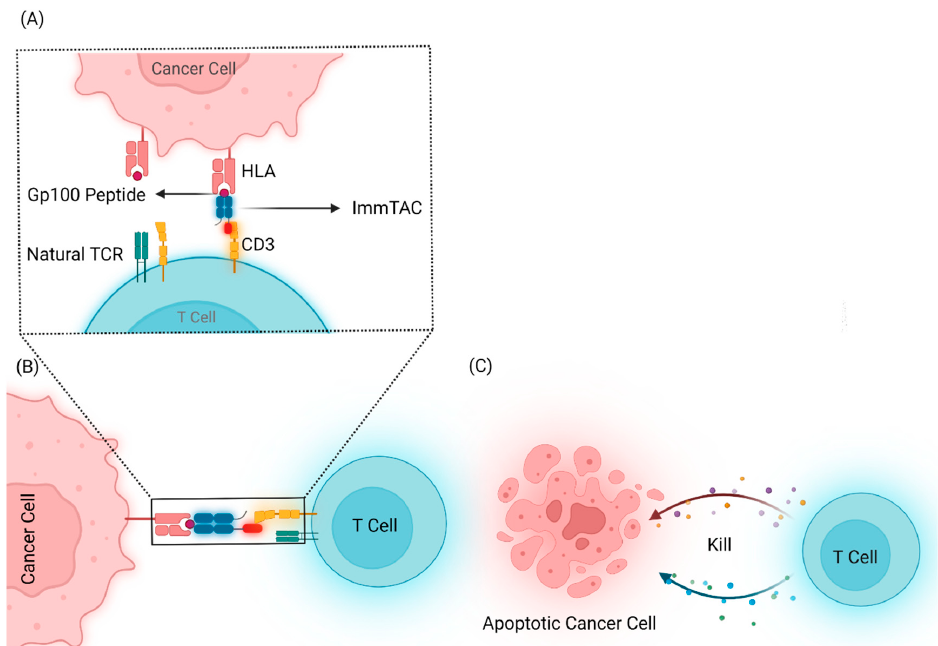
Figure 3. ( A ) ImmTAC molecules are T cell receptor (TCR) x anti-CD3 bispecific fusion proteins